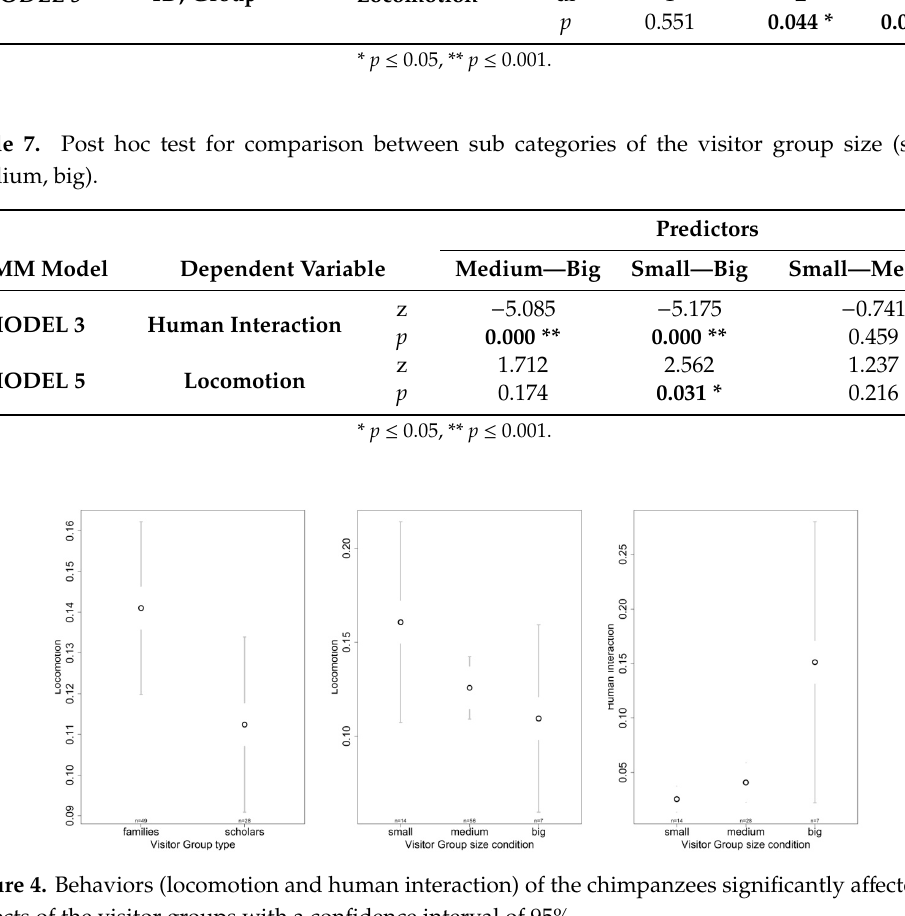
Table 7. Post hoc test for comparison between sub categories of the visitor group size (small, medium, big).